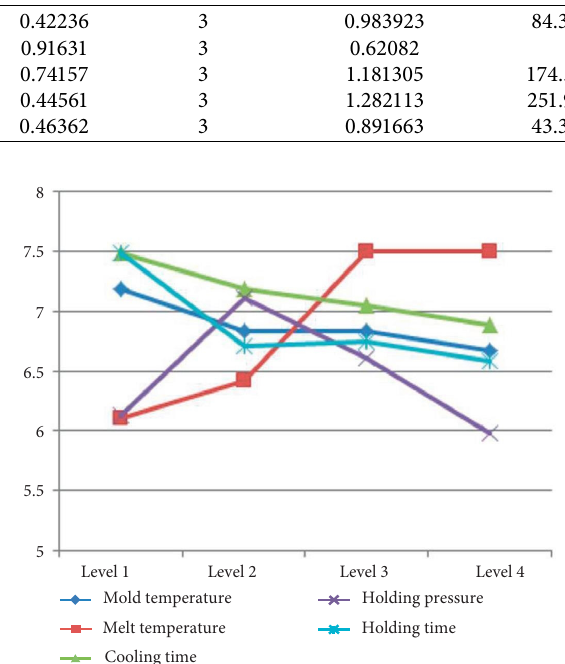
Figure 16: Warpage deformation range analysis line